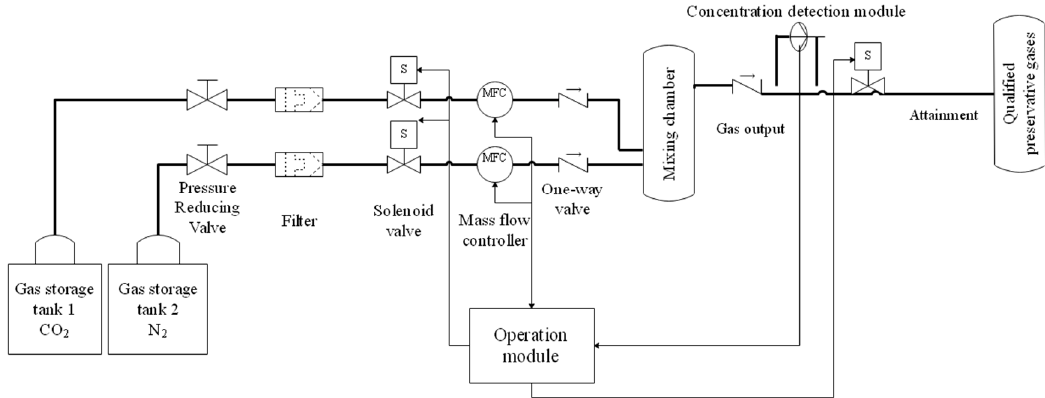
Figure 2. Workflow chart of the gas distribution system.